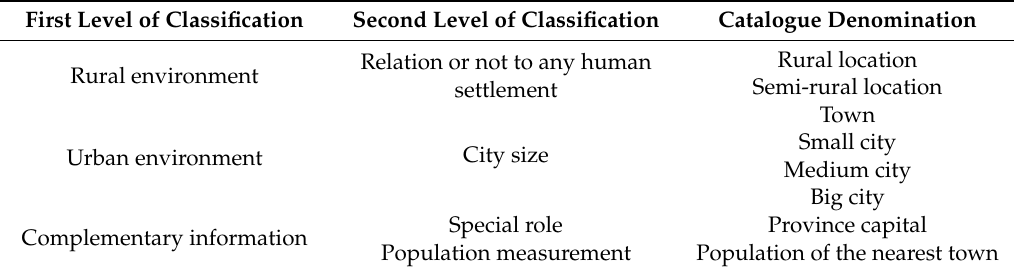
Table 1. Approach of the new classification criteria added to the catalogue structure.